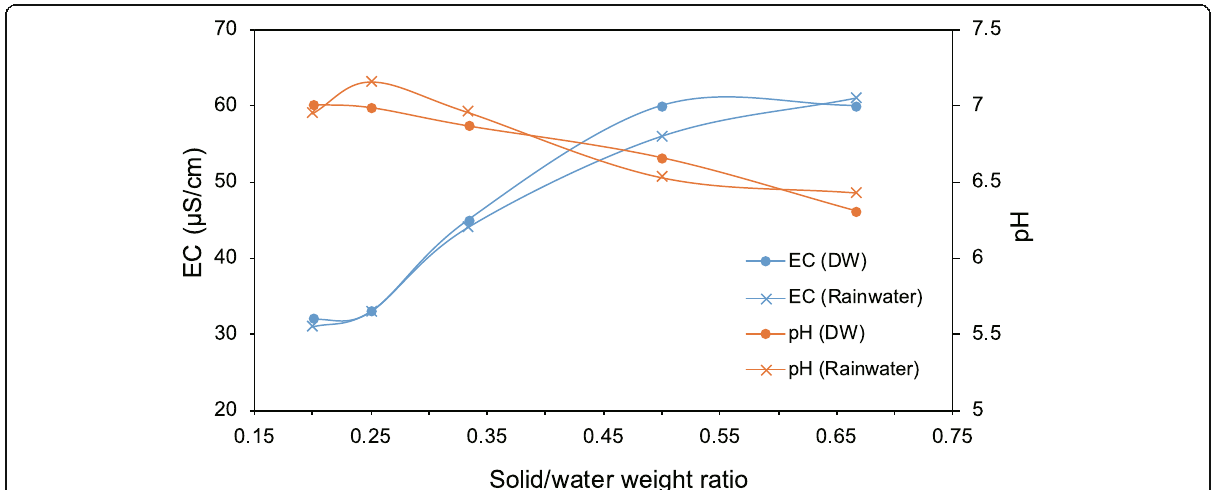
Fig. 7 Results of immersion tests. Changes in pH and electrical conductivity after sample immersion for 24 h in rainwater or distilled water (DW) at different solid/water weight